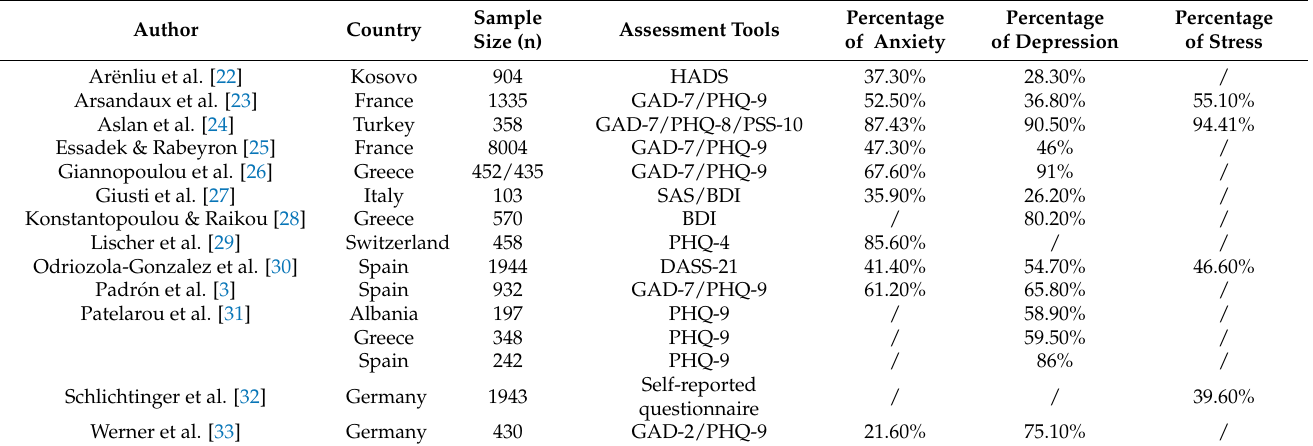
Table 1. Study Characteristics.